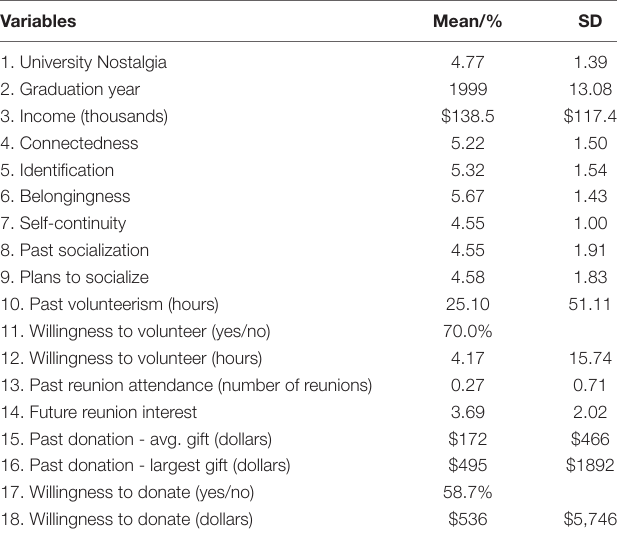
TABLE 1 | Descriptive statistics of study 1